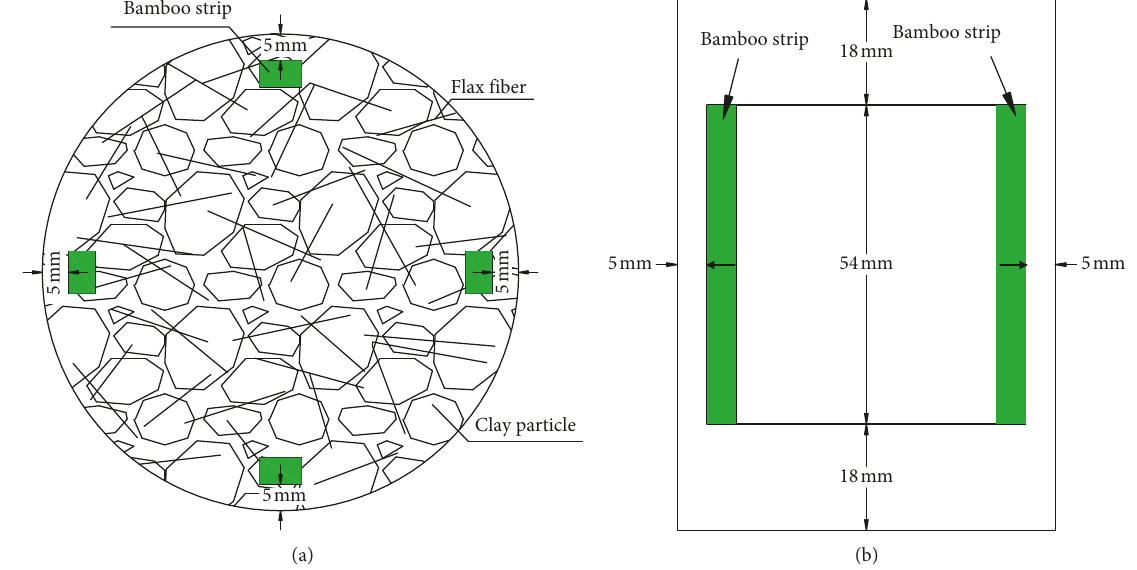
Figure 4: Arrangement of the bamboo strips and flax fiber composite reinforcement. (a) Cross section. (b) Vertical section.